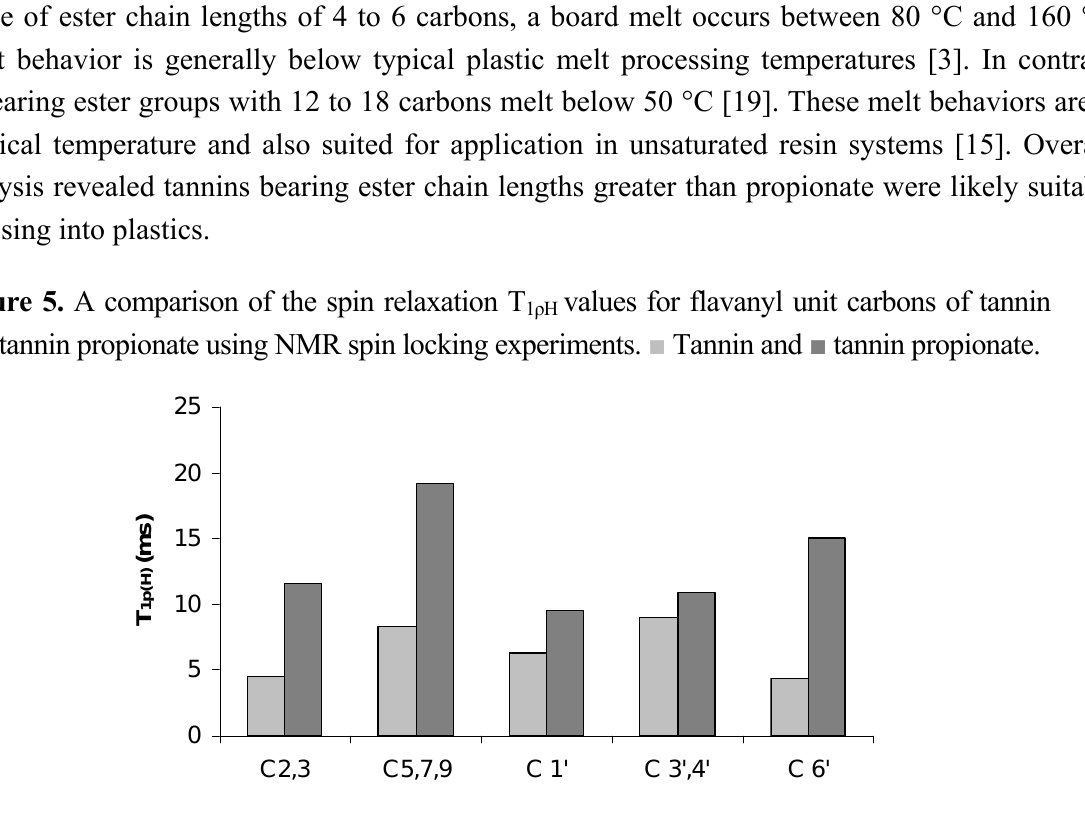
Figure 6. DSC thermograms of various tannin esters. Tannin acetate (orange), tannin propionate (blue), tannin hexanoate (DS = 2, red), tannin hexanoate acetate (black), tannin stearate (DS = 1, green) and tannin stearate (DS = 5, purple) with exo